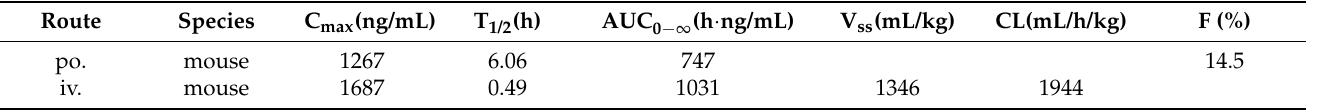
Table 4. Pharmacokinetics (PK) of Compound 20 *.